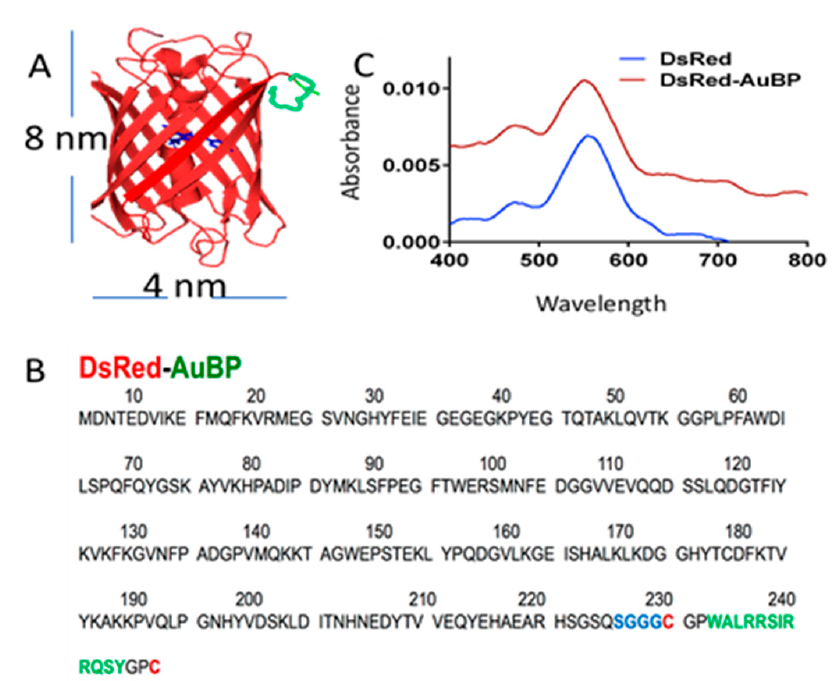
Figure 2. DsRed protein engineered with Au binding peptide. ( A ), The peptide insertion includes Au binding peptide (Green), linker (blue), and conformational domains (red and purple). ( B ), Insertion locations of DsRed-AuBP. ( C ), Fluorescence spectra showing that the properties of DsRed are conserved after the insertion of AuBP.